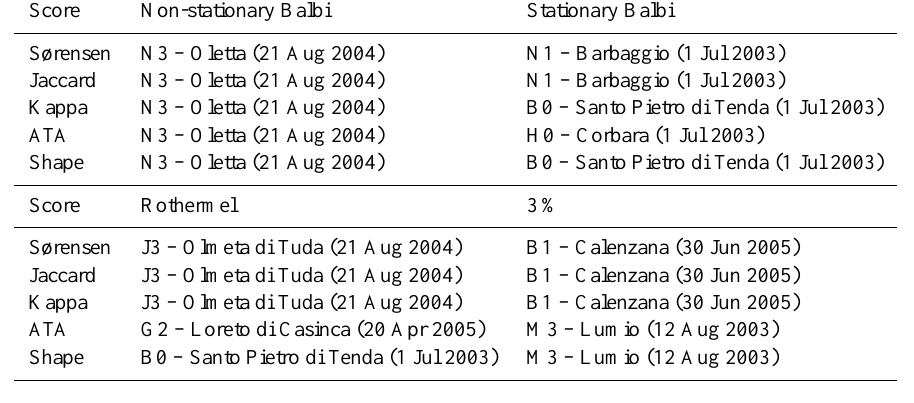
Table 2. The best simulations, according to the scoring method and the fire model. “ATA” stands for arrival time agreement. “Shape” refers to shape agreement. The final contours may be found in Figs. A1–A3, and further information about the fires is available in Table A1. Score Non-stationary Balbi Stationary Balbi